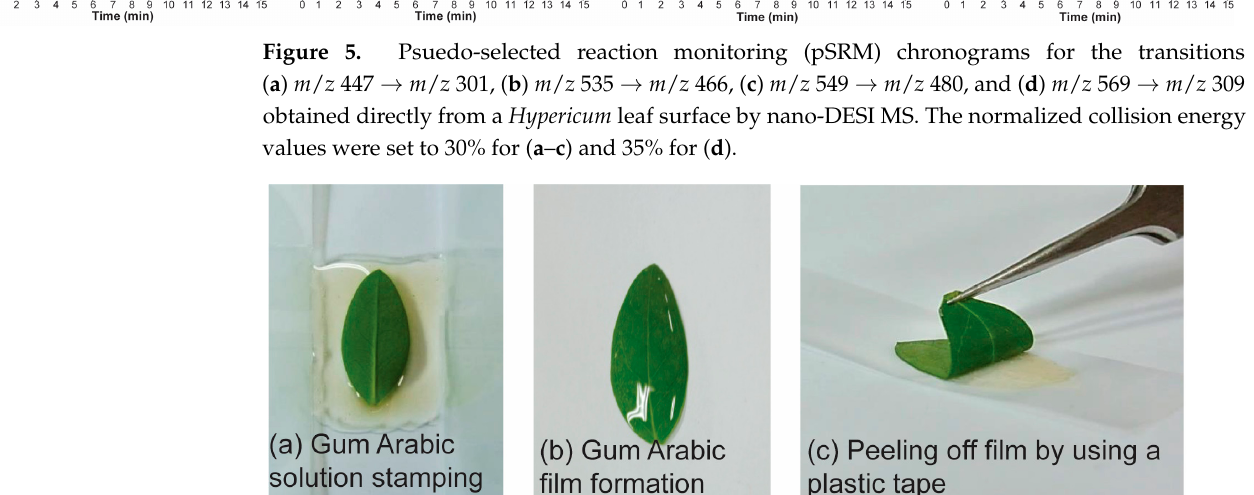
Figure 7. Nano-DESI mass spectra of the surface-layer-removed leaf samples in the negative ion mode. Mass spectra were acquired from the leaf surfaces whose surface layers were removed ( a ) two and ( b ) five times by polymeric gum Arabic film formation and detachment. The spraying sol- vent was EtOH. The abbreviation “deriv.” denotes “derivative”.